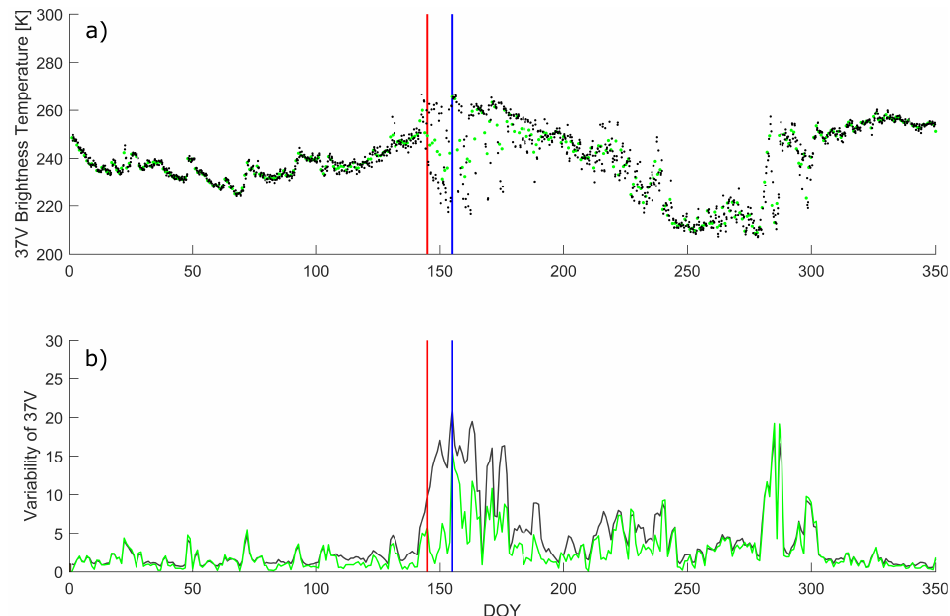
Figure 3. Data from pixel at [69.87 ◦ N, − 88.15 ◦ W], 2017. ( a ) Swath-to-swath TB37V data (black) and daily averaged TB37V data (green). ( b ) Standard deviation of swath data (black) and standard deviation of daily averaged data (green). The vertical red line indicates the MO date using swath-to-swath data and the Dynamic Threshold Variability Method (DTVM). The vertical blue line indicates the MO date using daily averaged data and the